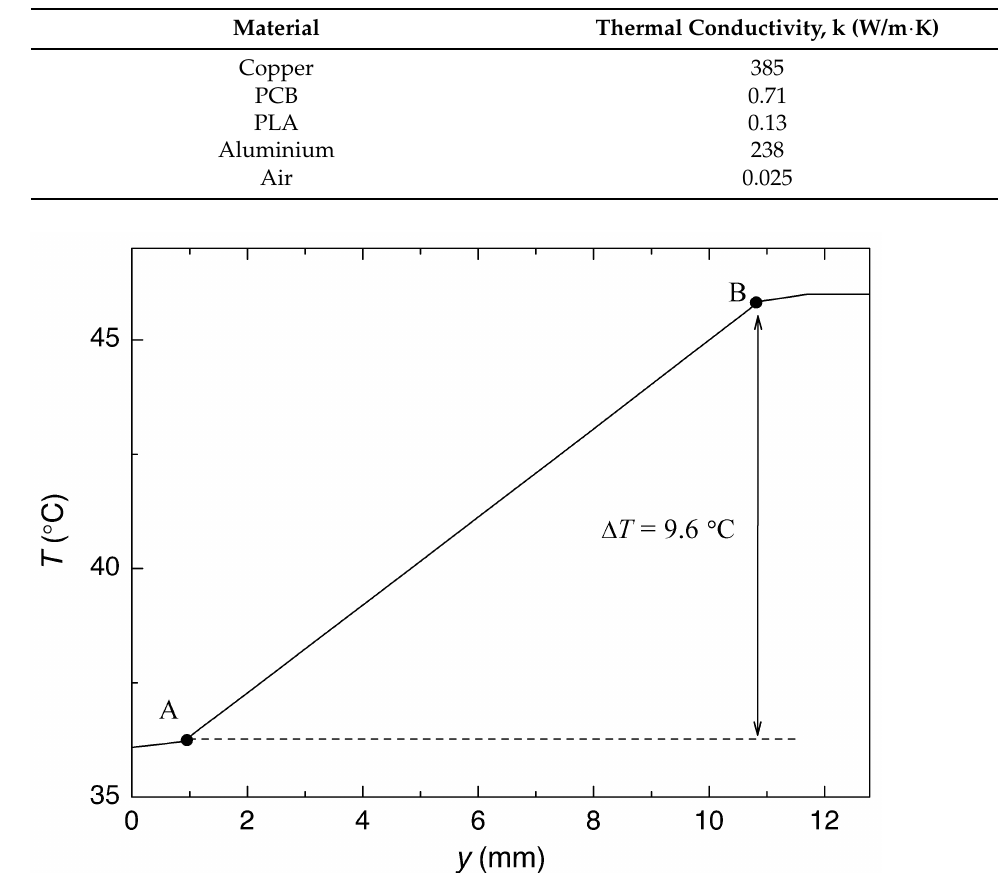
Figure 7. Simulated temperature distribution of a cross-section of the sensor. Table 4. Simulation settle.